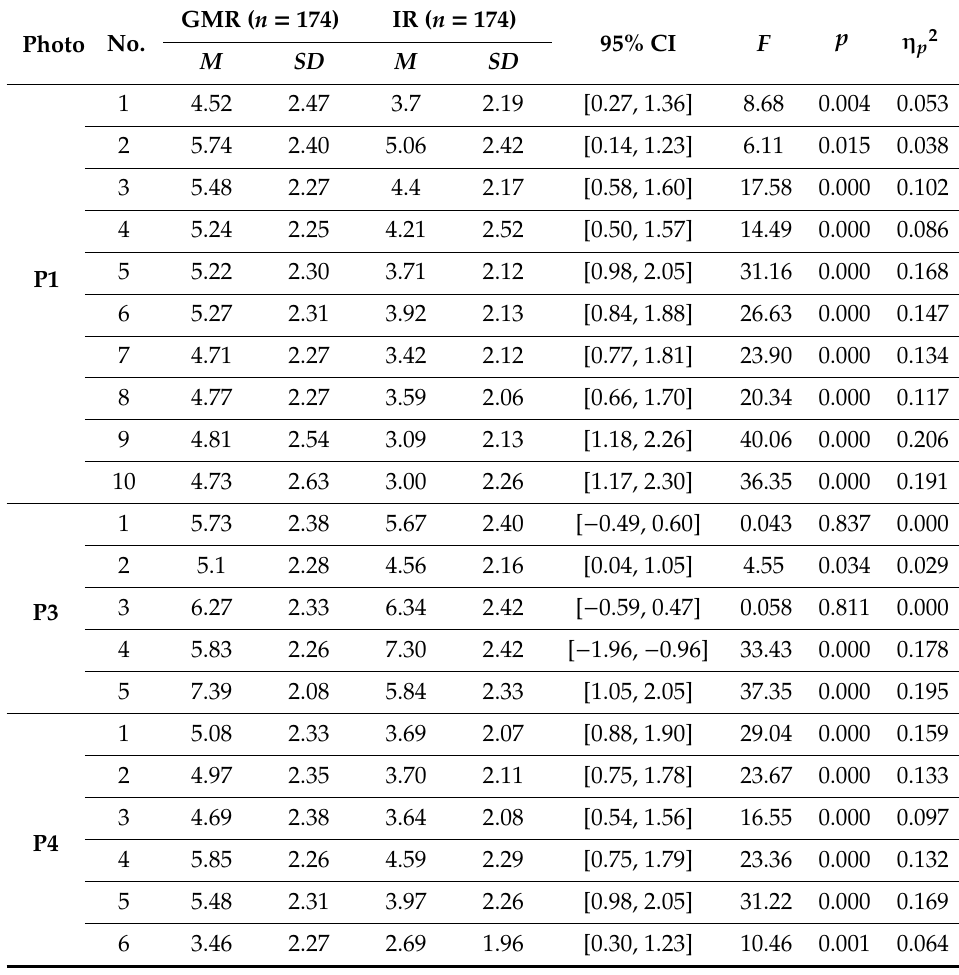
Table 5. Comparisons between IR and GMR from Study Ib ( n = 155). Photo